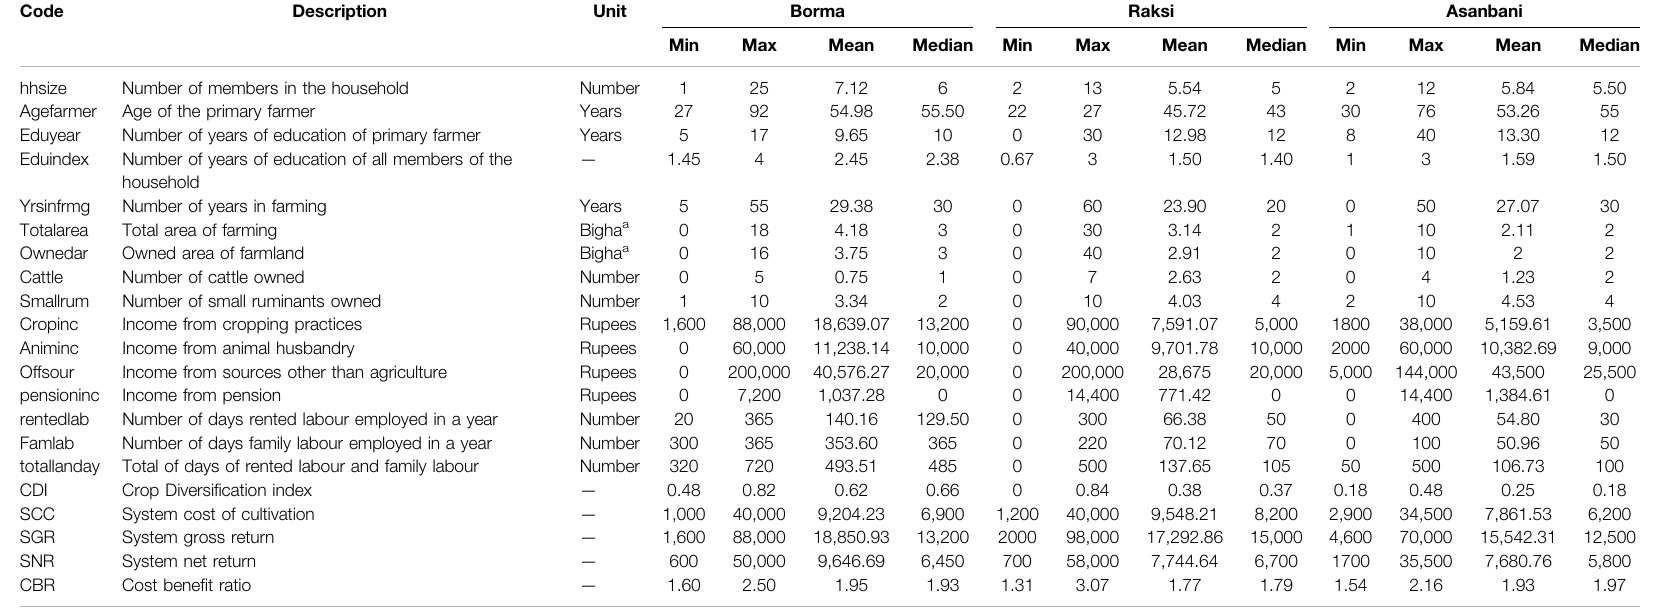
TABLE 1 | Summary statistics of surveyed variables from the three villages for characterization of farm household.